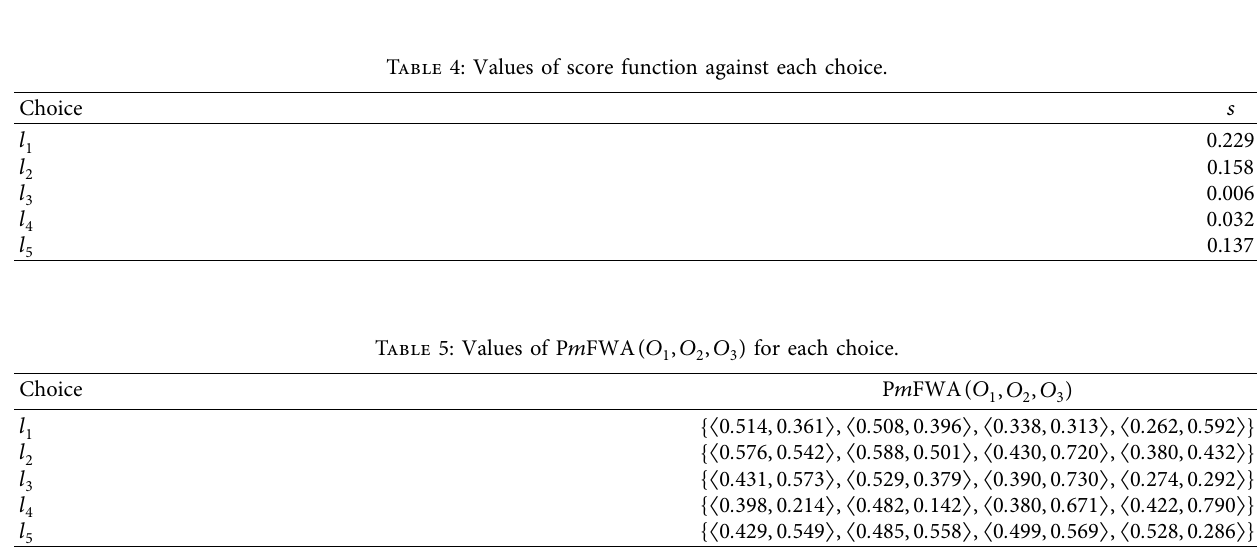
Table 3: Values of P m FWA ( O